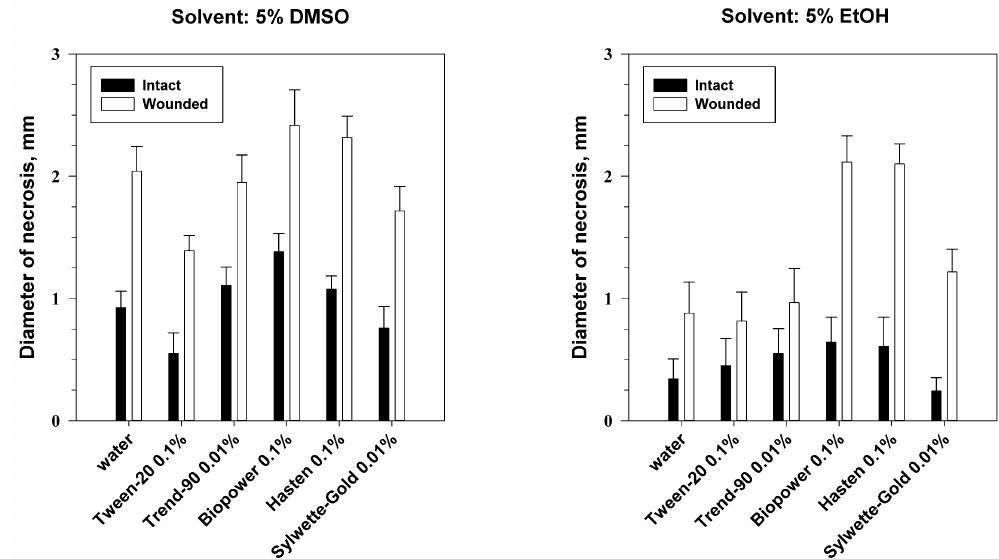
Figure 5. Effect of leaf damage, solvent and adjuvants on phytotoxicity of phaeosphaeride A on leaf discs of C. arvense . Least significant difference (LSD) 0.05 = 0.53, bars indicate standard deviation at p = 0.05.